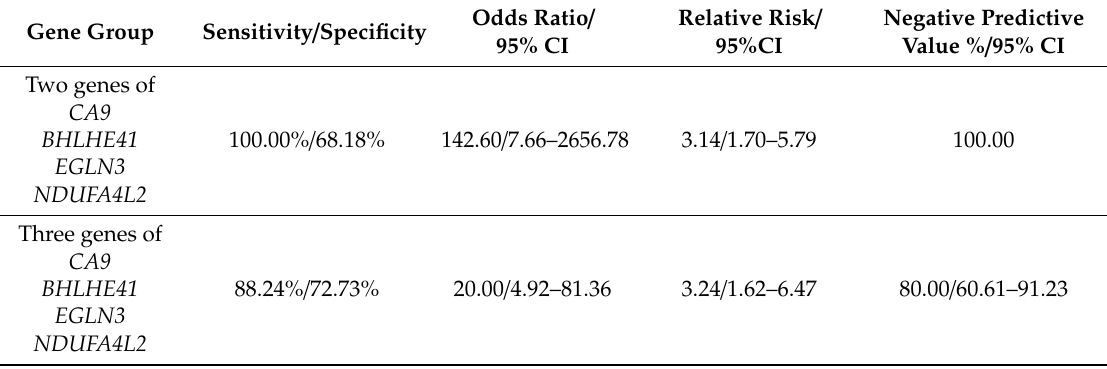
Table 4. Relationship of simultaneous expression of several genes with the development of ccRCC metastasis within 1